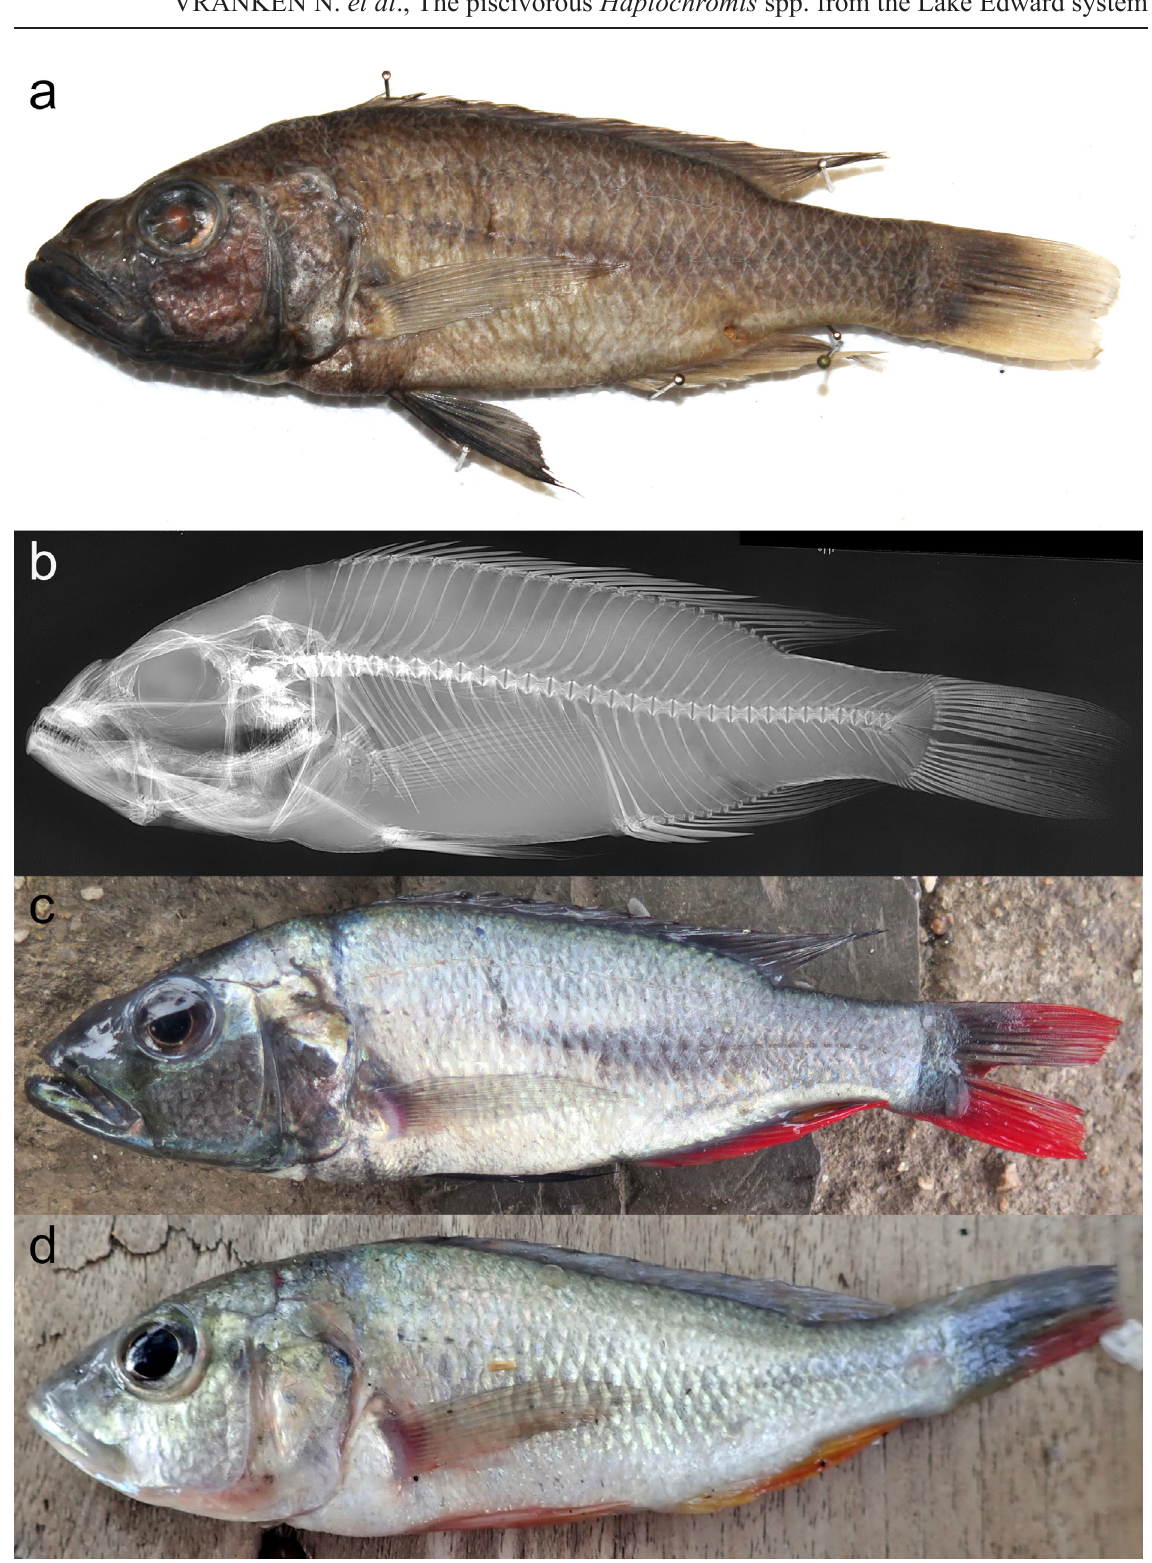
Fig. 21. Haplochromis aquila sp. nov. a . Photograph of preserved holotype (RMCA 2018.008.P.0355; 113.6 mm SL). b . X-ray image of holotype. c – d . Photographs of freshly caught specimens. c . Dominant male, the holotype. d . Female (RMCA 2018.008.P.0352; 108.7 mm SL) to illustrate the live colour patterns. The contrast was slightly